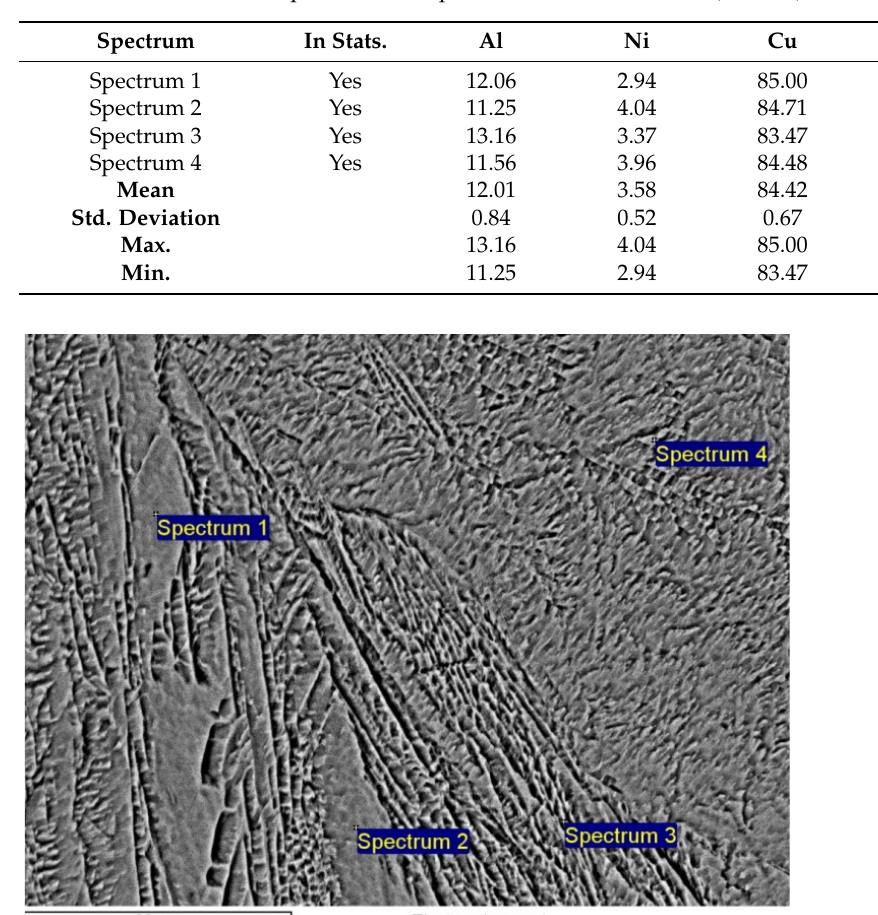
Figure 2. SEM characteristic microstructure of the Cu-Al-Ni disc with presentation of the EDX analysis sites.